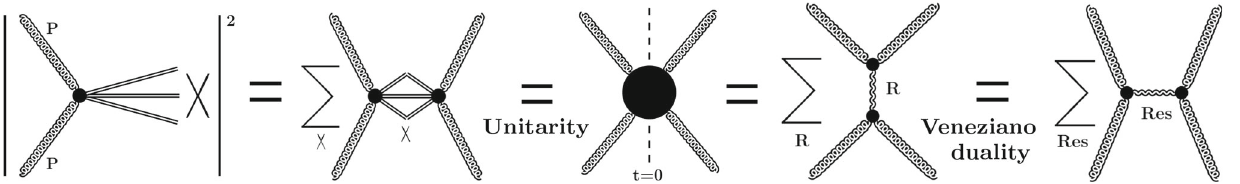
Fig. 7 Connection, through unitarity (generalized optical theorem) and Veneziano-duality, between the Pomeron–Pomeron cross section and the sum of direct-channel resonances (DAMA) [14]. For s → ∞ and fixed t it is